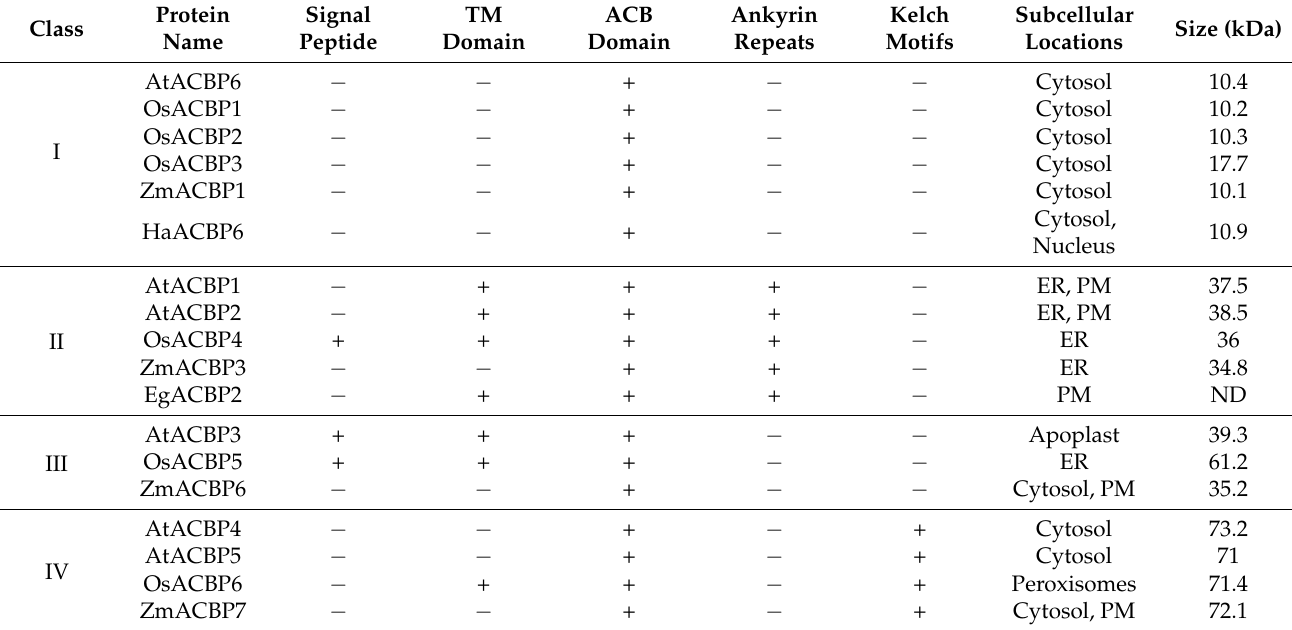
Table 1. Characterization of plant